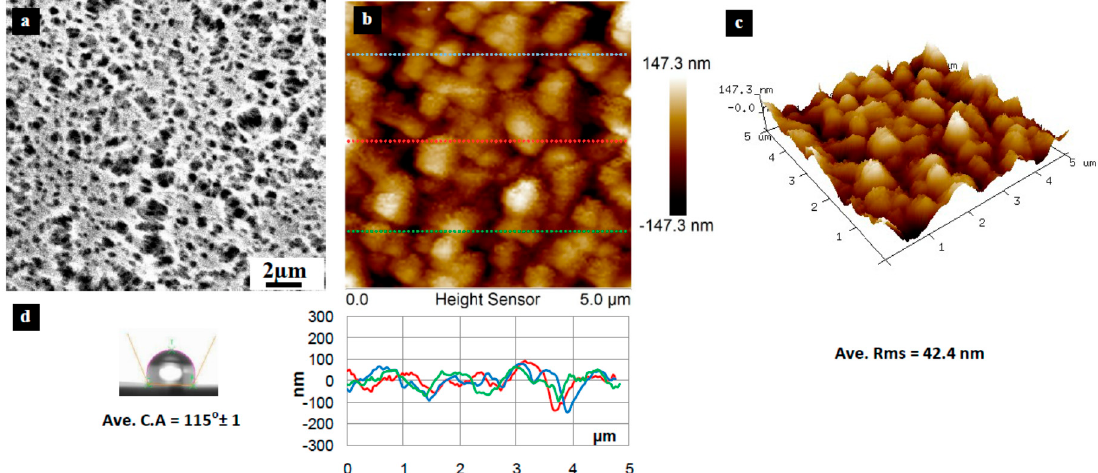
Figure 3. Surface characteristics of the as received PP substrate (100 nm pore size), ( a ) SEM micrograph; ( b ) 5 × 5 µm 2 AFM image (top) and three section profiles (bottom) with an average RMS equal to